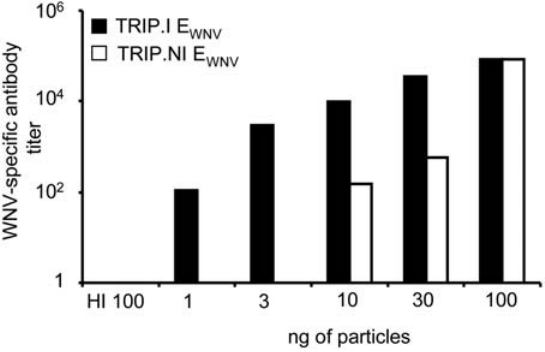
Figure 3. A single dose of nonintegrative lentiviral vector coding for E WNV elicits a strong and specific antibody response. Groups of adult mice (n=6) were immunized intraperito- neally with graded doses (1–100 ng of p24 antigen) of TRIP.NI E WNV or TRIP.I E WNV particles. Control mice were inoculated with 100 ng of heat- inactivated (HI) particles. After 21days, pooled sera (6 mice per group) were assessed for the presence of WNV-specific antibodies. Data are representative of three independent experiments.